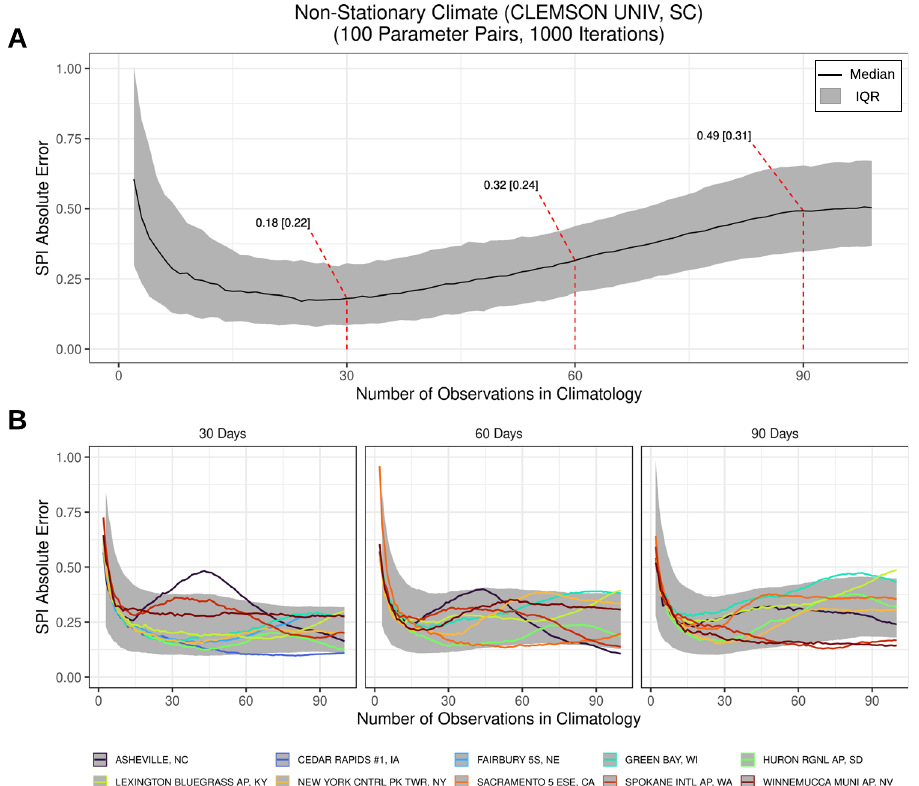
Fig. 4 Summary of simulation results for a non-stationary distribution using the observed 30-year moving window gamma parameters from 11 Global Historical Climatology Network (GHCN) sites. The Standardized Precipitation Index (SPI) was estimated by fi tting a gamma distribution to random samples of differing lengths, with each random sample being generated by the observed moving window generative gamma distribution for each site. The absolute SPI error was then computed using the known SPI value from the known (observed 30-year moving window) distribution for the most recent observation (e.g. 2020, consistent with operational SPI calculations). A Detailed simulation results for GHCN site USC00381770 located at Clemson University in South Carolina for the 30-day SPI for August 1st. Black lines and gray ribbons represent the median [interquartile] value of the 1000 simulations. B Results for 10 additional GHCN sites for various geographical locations and 30-, 60- and 90-day timescales for August 1st. Gray shading represents the interquartile range for simulations at all sites for each